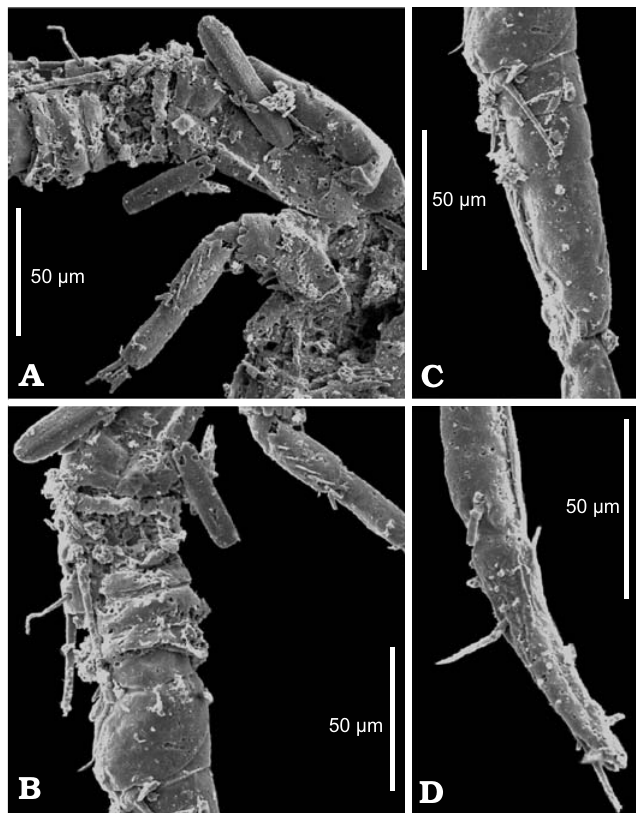
Fig. 4. Cyclopid copepod Apocyclops californicus sp. nov. (UMNH IP 4850) from Mud Hills, Southern California; Burdigalian–Langhian, Miocene, adult male antennule in ventral view. A . Segments 1 − 8 (I − XIII) and antenna with allobasis. B . Segments 1 − 11 (I − XVI). C .